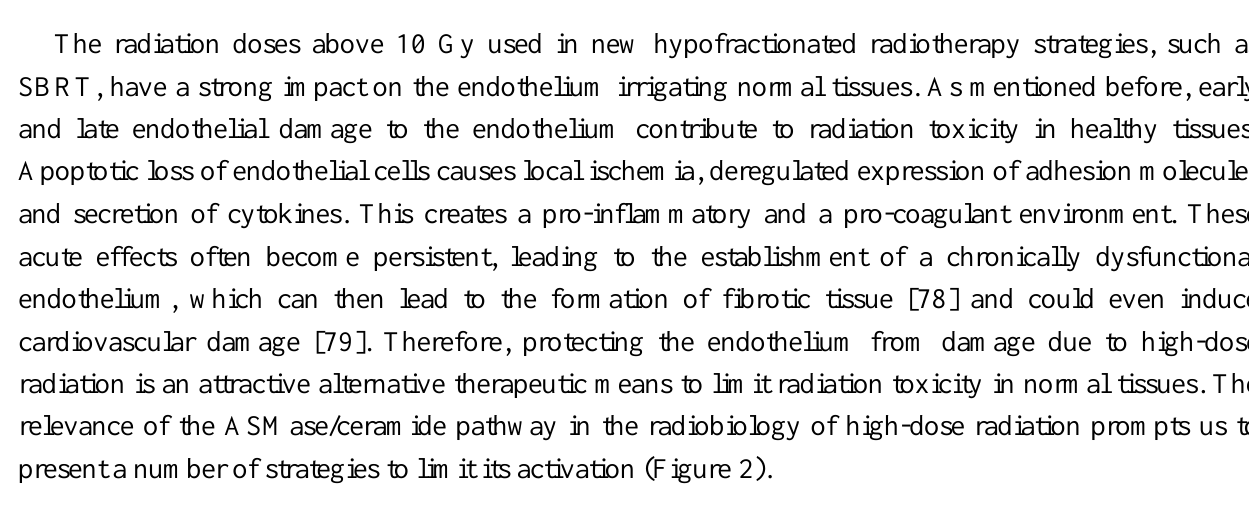
Figure 2. Targeting the ASMase pathway in the endothelium. See text for